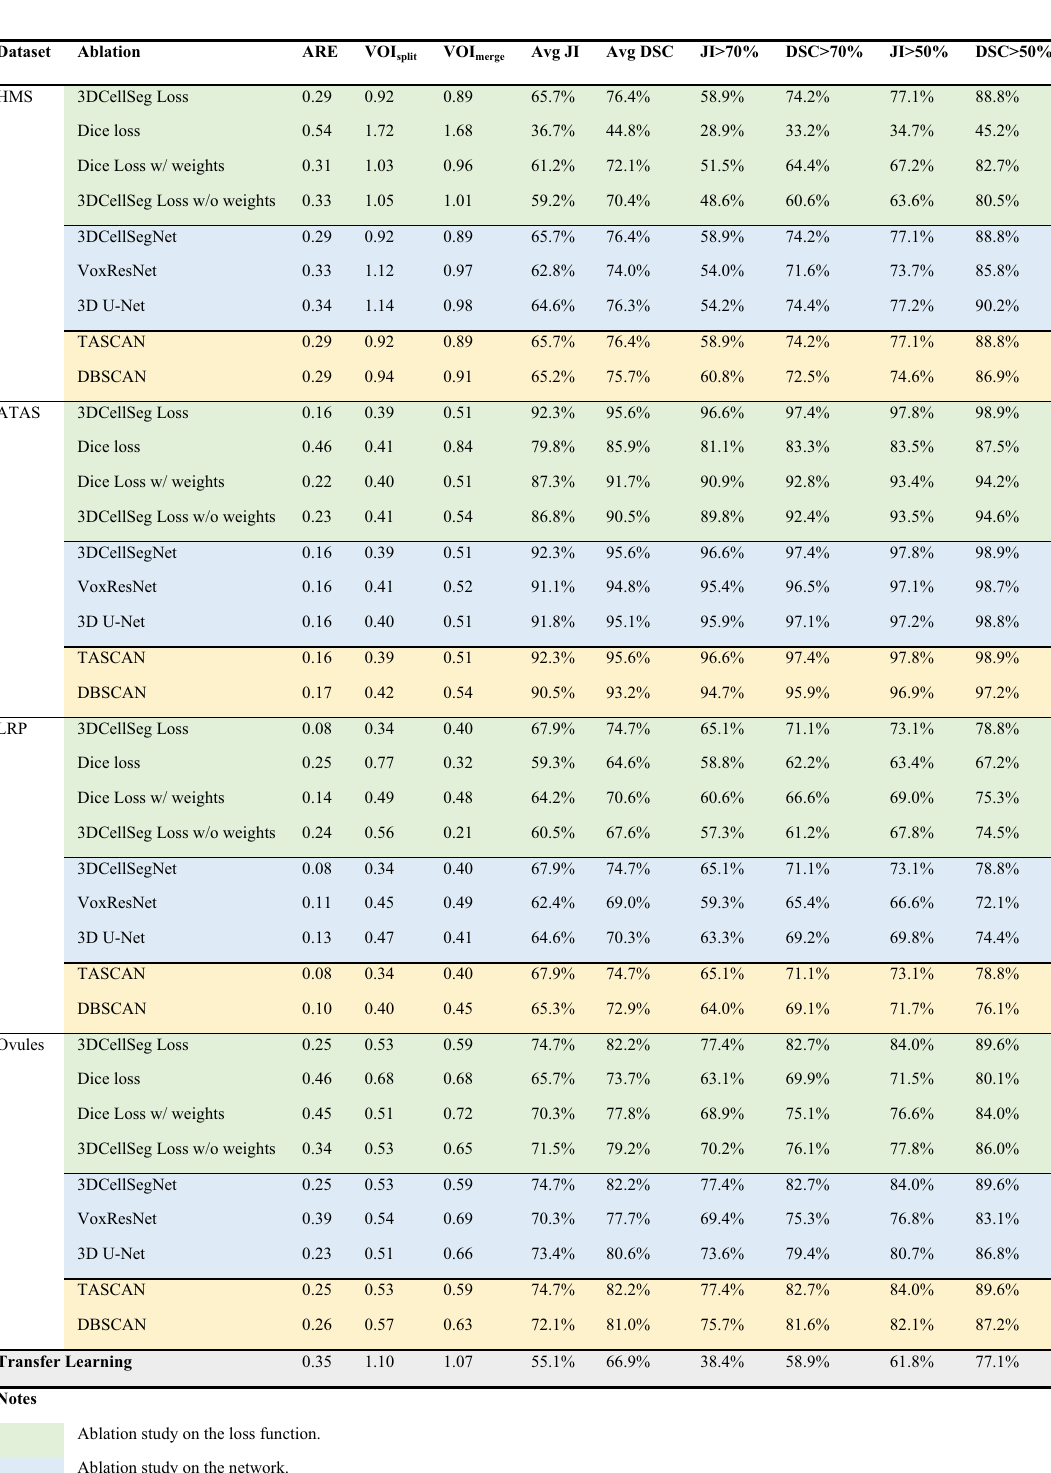
Table 4. Ablation studies showing 3DCellSeg Loss, 3DCellSegNet, TASCAN, and Transfer